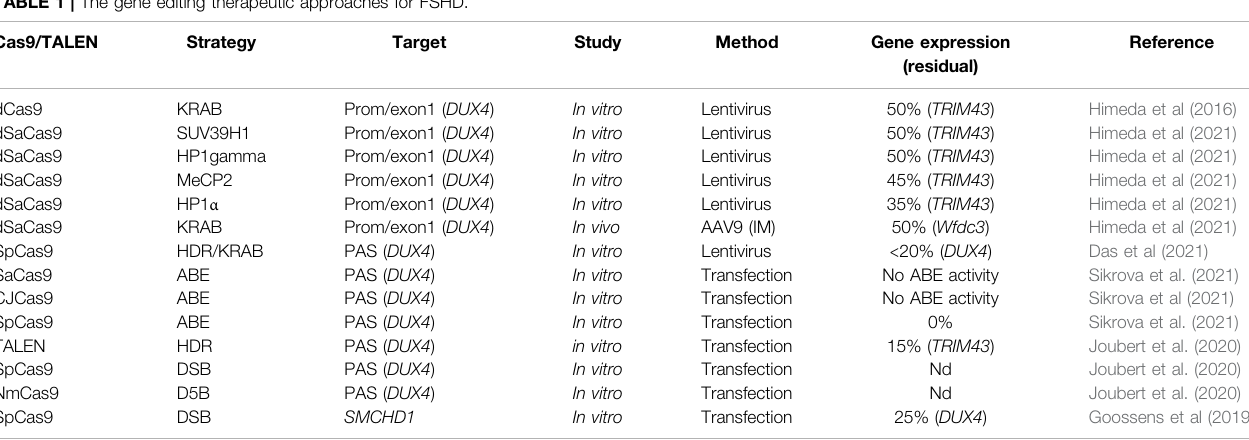
TABLE 1 | The gene editing therapeutic approaches for